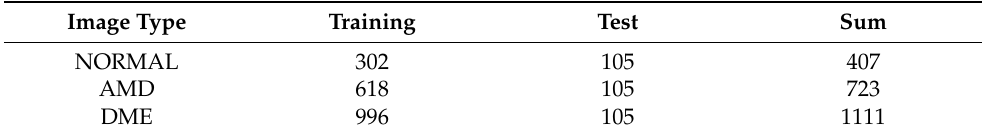
Table 2. Data settings of the Srinivasan 2014